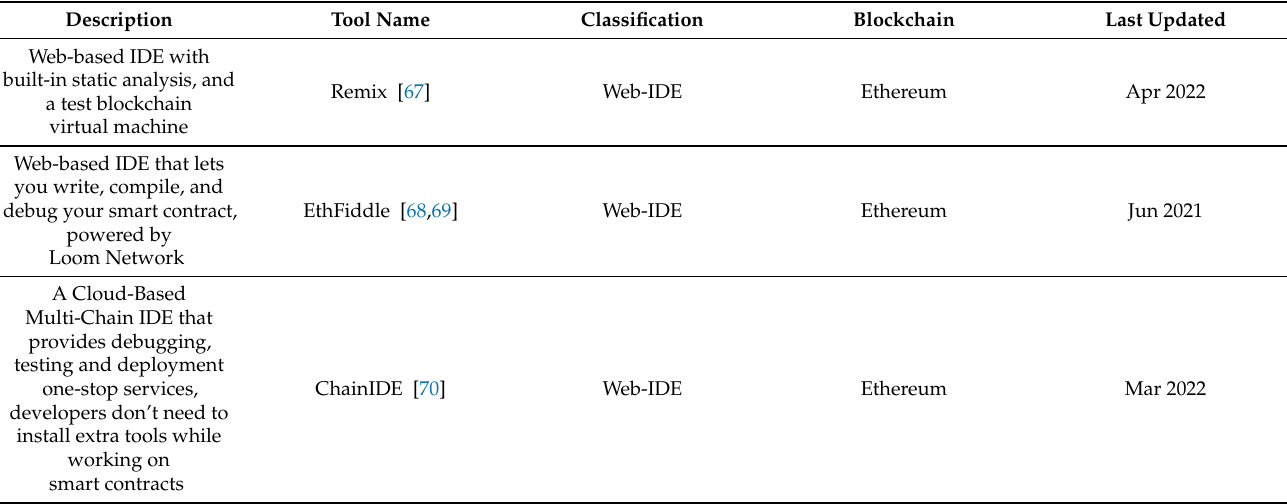
Table 3. Blockchain development tools for IDE